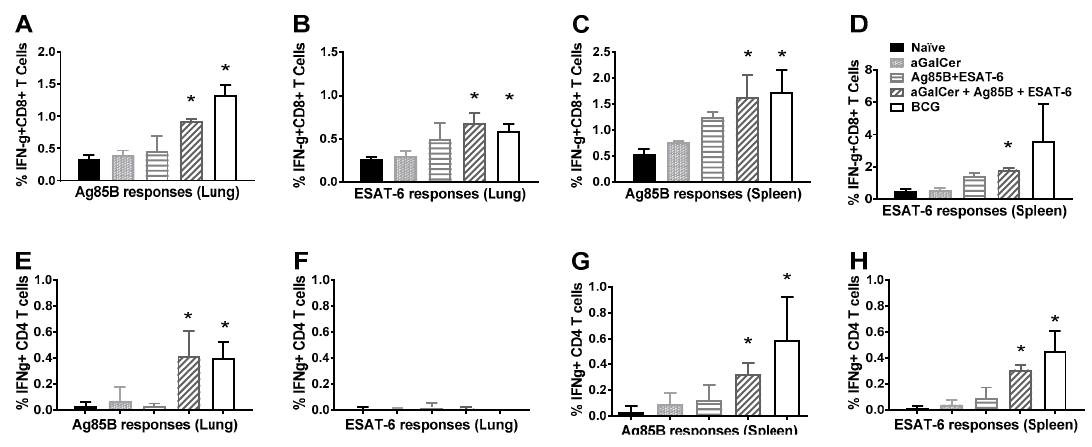
Figure 5. Sublingual immunization with Mtb proteins Ag85B and ESAT-6 in the presence of α -GalCer adjuvant affords protection against lung Mtb challenge through inducing antigen-specific CD4 and CD8 T cell responses. C57BL/6 female mice were immunized by the sublingual route as in Figure 1 and challenged on day 28 with Mtb by aerosol. Cells isolated from the lung and spleen tissues were analyzed on day 56 (28 days post challenge) by intracellular cytokine flow cytometry for IFN- γ producing CD8 (Panels ( A – D )) and CD4 T (Panels ( E – H )) cells in response to stimulation with the Mtb proteins Ag85B and ESAT-6. Significance (*, p < 0.05) was calculated by ANOVA analyses for comparing values between naïve animals and those vaccinated with the combination of the Mtb proteins plus α -GalCer or the BCG. The experiment was performed using 5 mice/group.